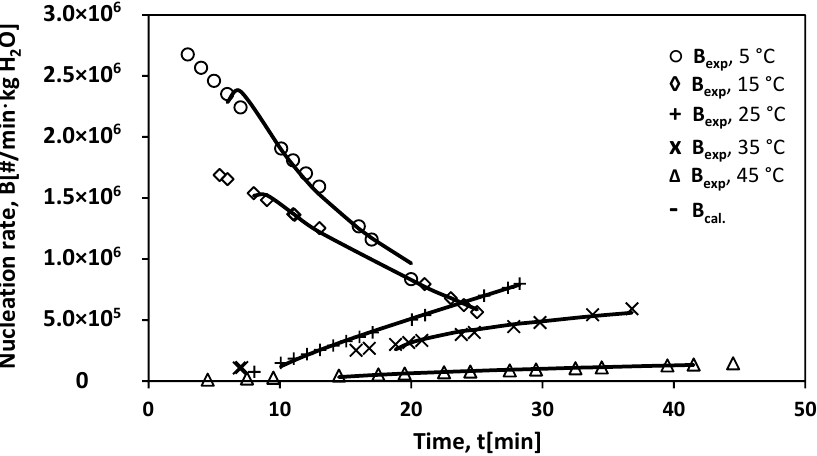
Figure 6. Experimental and calculated nucleation rates B exp [#/min · kg H 2 O] (symbols) and B cal (line) as a function of time for different S 0 obtained at 5, 15, 25, 35 and 45 °C.